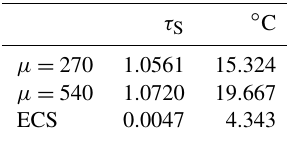
Table 3. ECS for the globally averaged